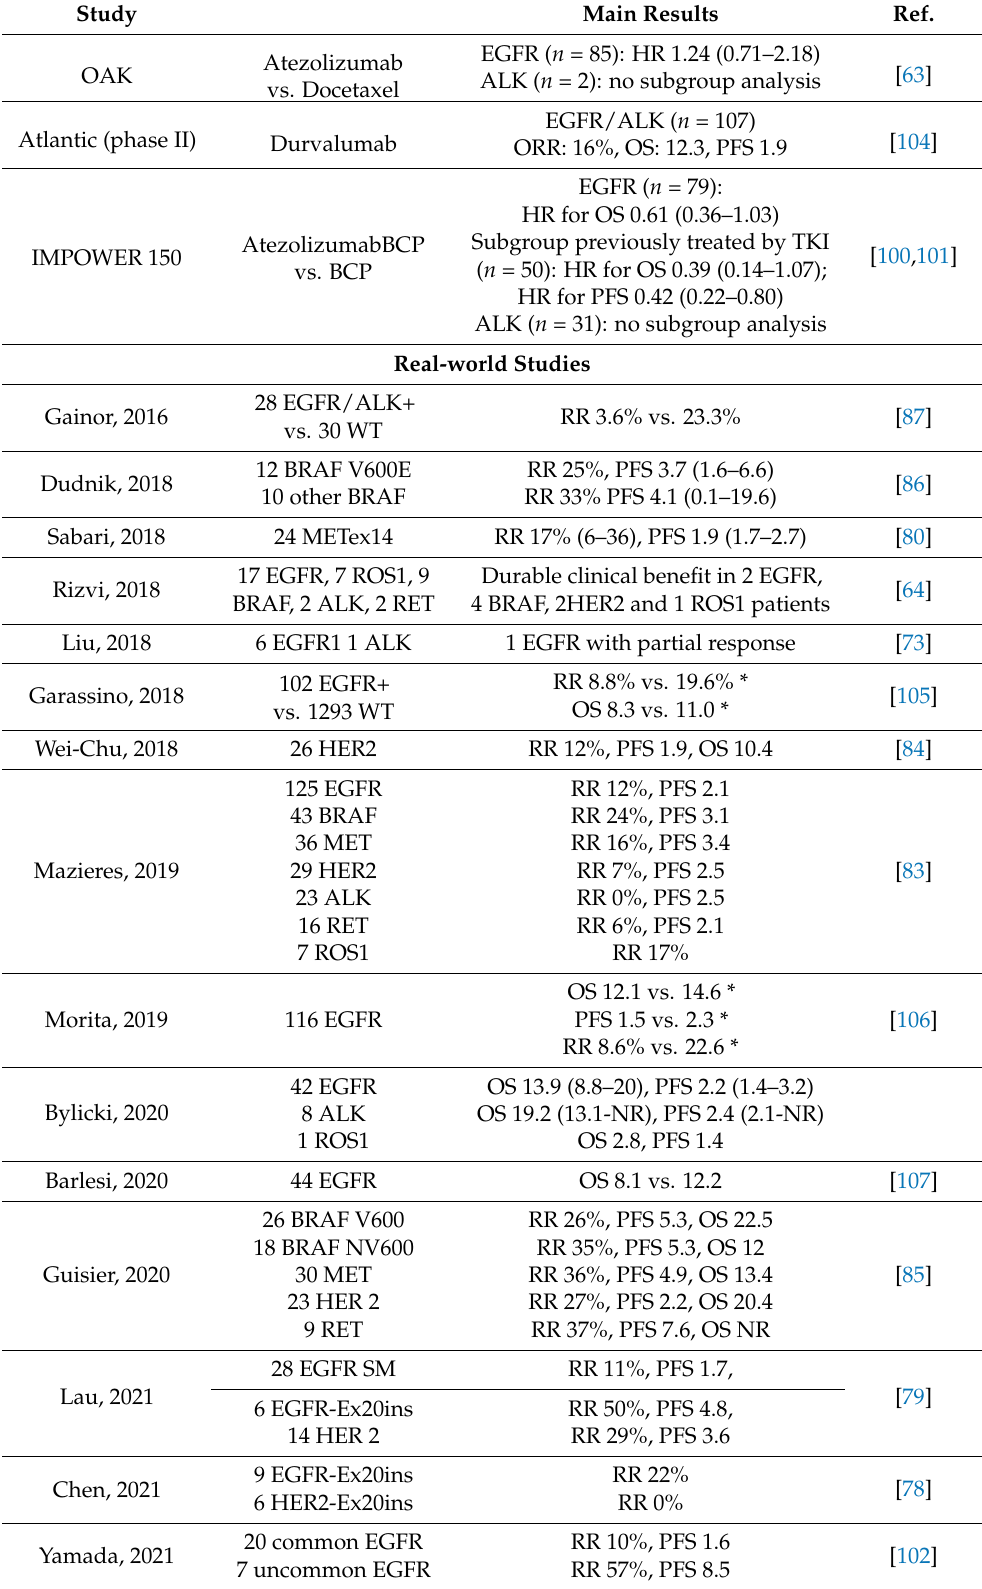
Table 4. Cont. Study Main Results